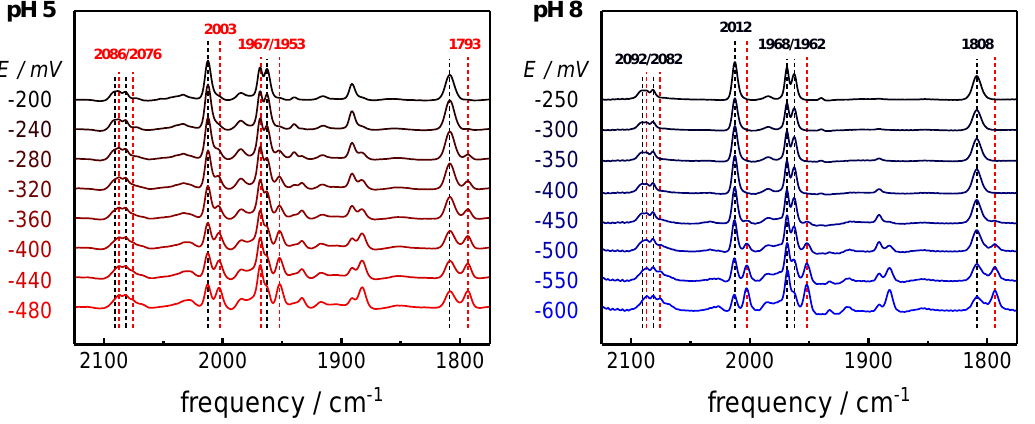
Figure 2. Formation of the one-electron reduced state, CO-inhinbited state Hred´-CO at pH 5 and pH 8. The spectra show the gradual population of Hred´-CO (red band frequency labels) at the expense of Hox-CO (black band frequency labels) for a step-wise decrease of redox potential at pH 5 (left panel) or pH 8 (right panel). Spectra were normalized to uniform integral band intensity. Minor bands are due to small reduced H-cluster species Hred and Hsred populations (e.g., at 1891 cm − 1 and 1882 cm − 1 ) and unrelated to the CO-inhibited states.